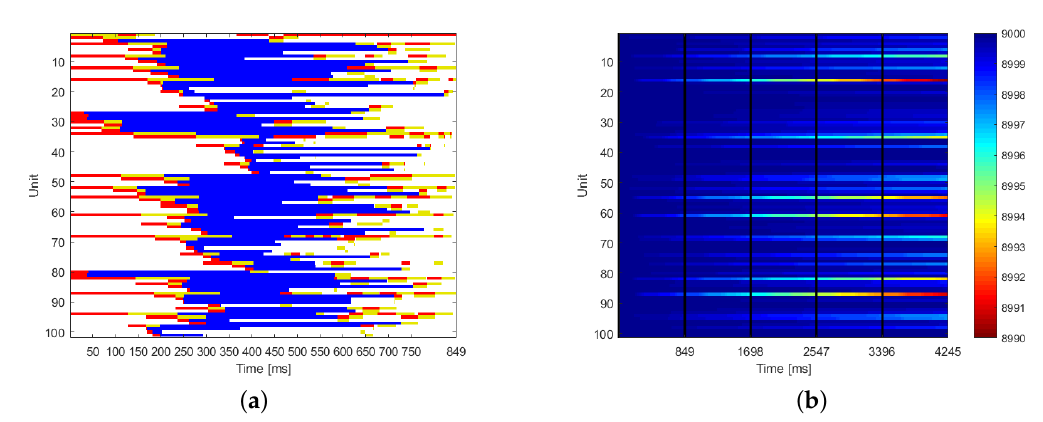
Figure 11. Best solution: scheduling and energy level. ( a ) Scheduling of one elaboration cycle. Red represents the receiving mode, blue the elaboration status, and yellow the transmitting mode. ( b ) Energy level for each sensor in the first five elaboration